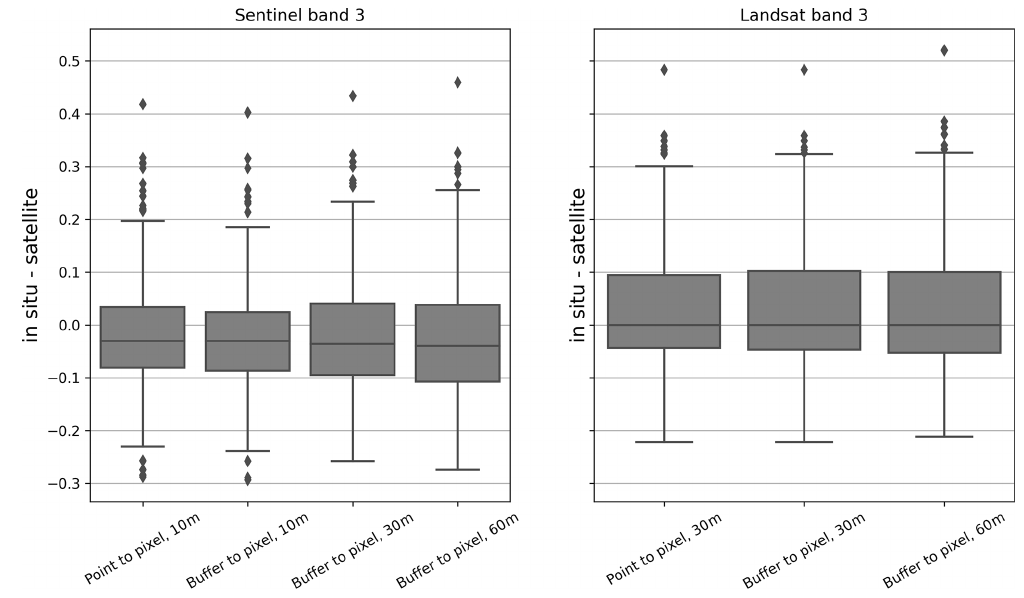
Figure 11. For the respective Sentinel and Landsat band-3 wavelength range, the difference between the in situ HCRF and satellite surface reflectance product is on the vertical axis. Point to pixel refers to the data as presented in previous figures. Buffer to pixel refers to data generated using a buffer around the in situ measurement points to account for GPS accuracy. For Sentinel, the original 10m resolution data were resampled to 30 and 60m. For Landsat, the original 30m resolution data were resampled to